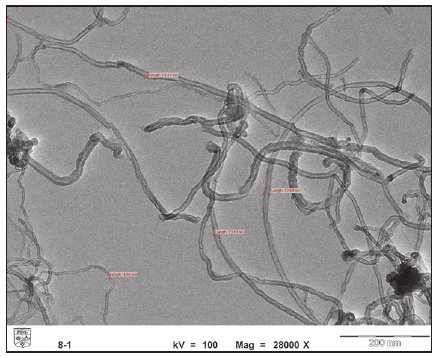
Figure 4: Carbon nanofiber (CNFs) particles under